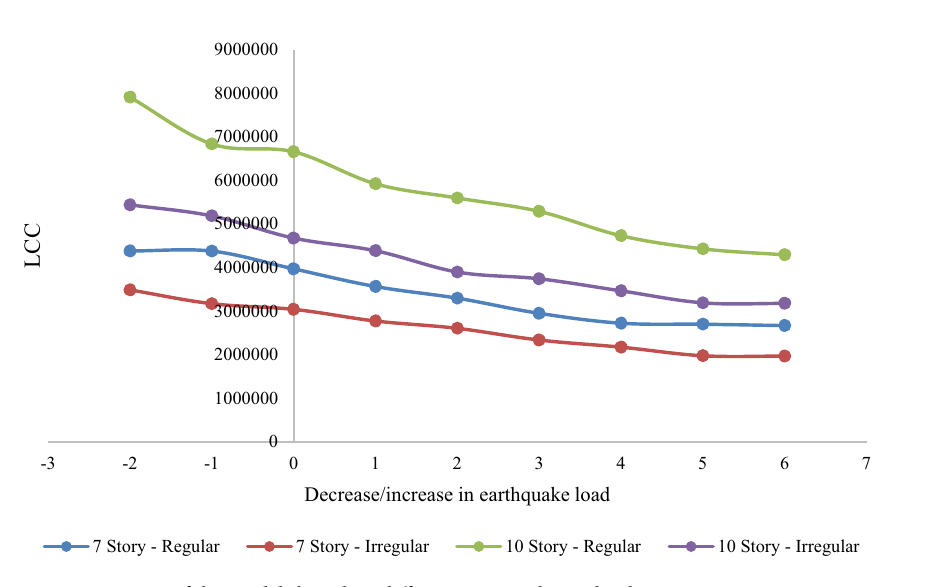
Figure 8. LCCs of the models based on different seismic design loads.